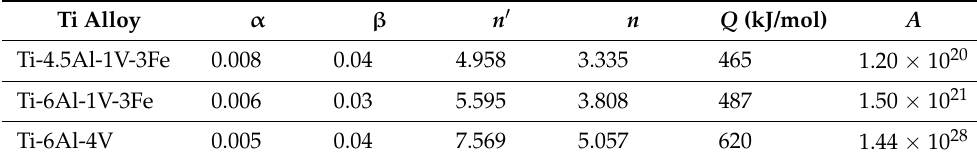
Table 1. Constitutive parameters for titanium alloys investigated